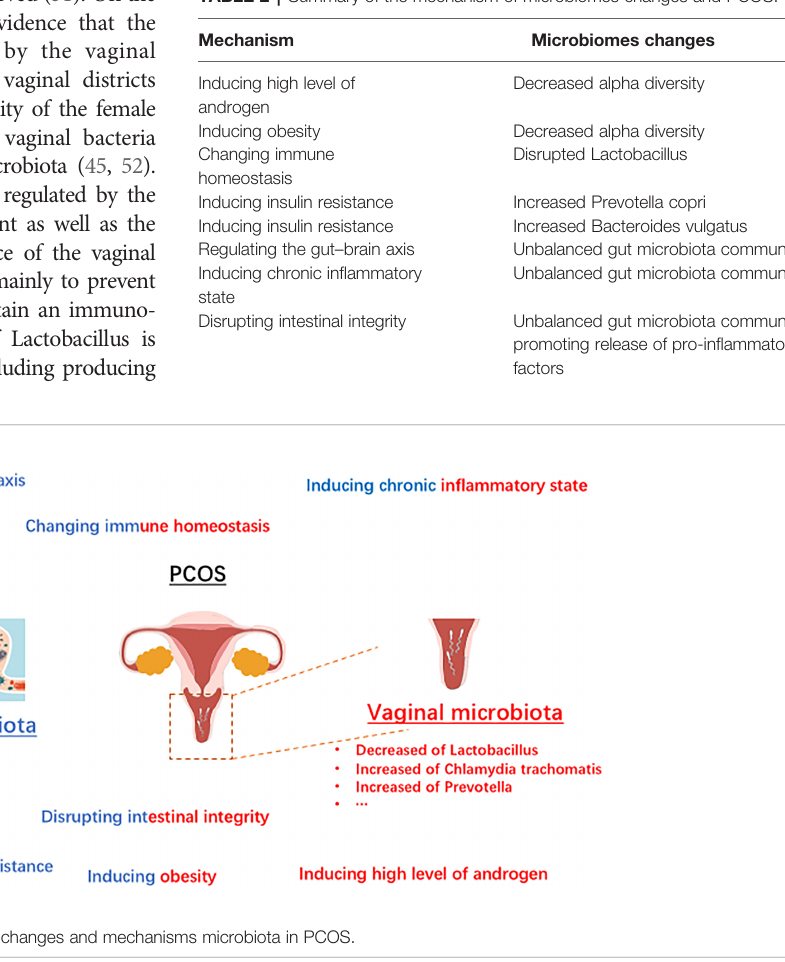
TABLE 2 | Summary of the mechanism of microbiomes changes and